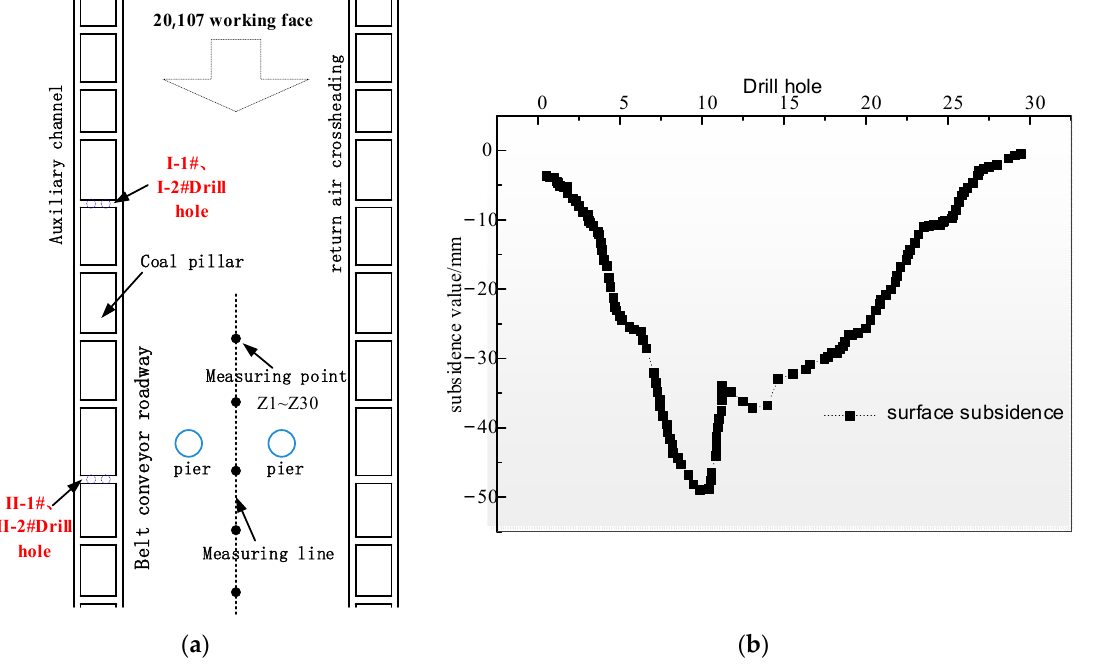
Figure 12. Surface Profile Subsidence Prediction Map: ( a ) Surface station layout plan; ( b ) Surface subsidence profile.